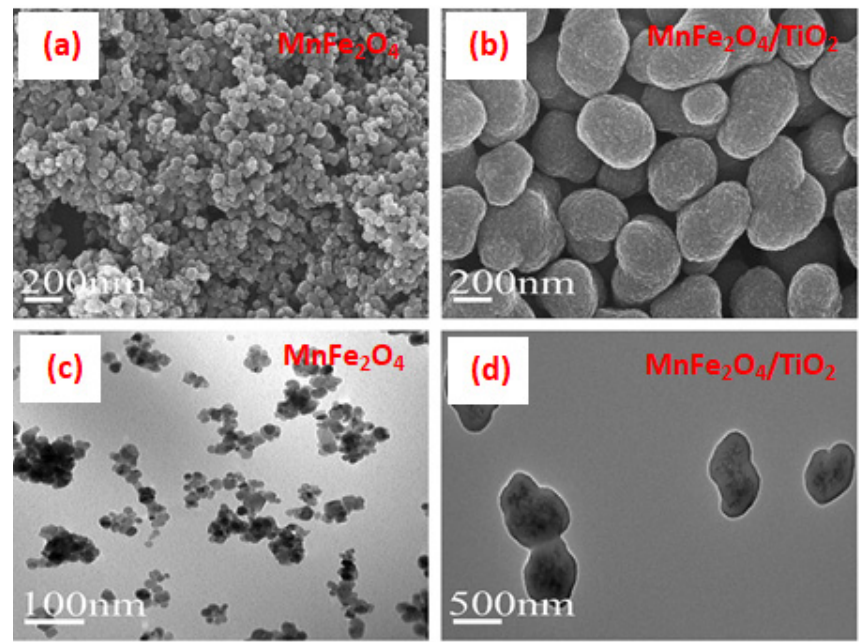
Figure 8. XRD patten of MnFe 2 O 4 and MnFe 2 O 4 /TiO 2 nanocomposites [106]. Republished with per- mission from Elsevier.